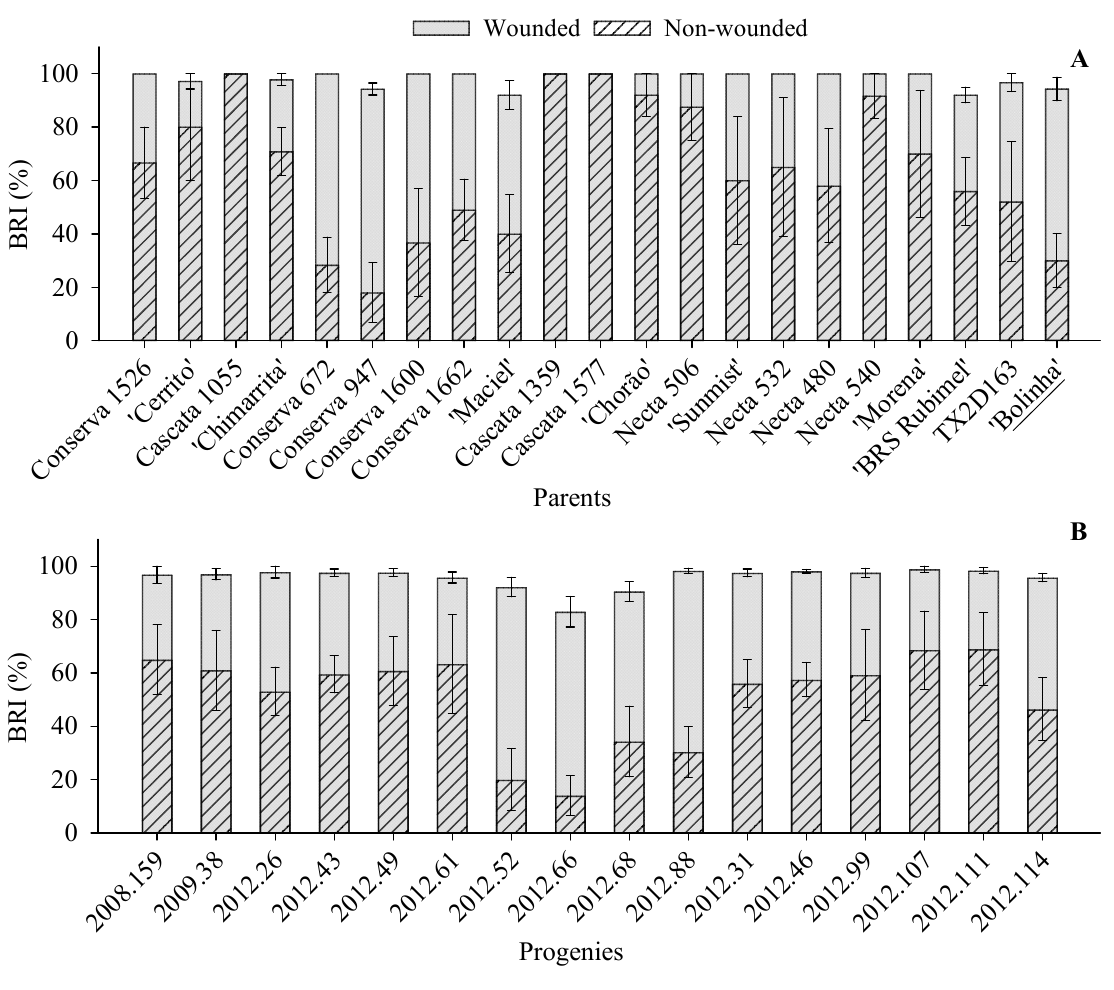
Figure 1. Brown rot incidence (BRI) on wounded and non-wounded (W and NW) fruits of parents ( A ) and progeny ( B ) average for three and two seasons (2015–2016; 2016–2017; 2017–2018 and 2016–2017; 2017–2018, respectively). ‘Bolinha’ was included as control. Embrapa Peach Breeding Program, Pelotas, Rio Grande do Sul, Brazil.